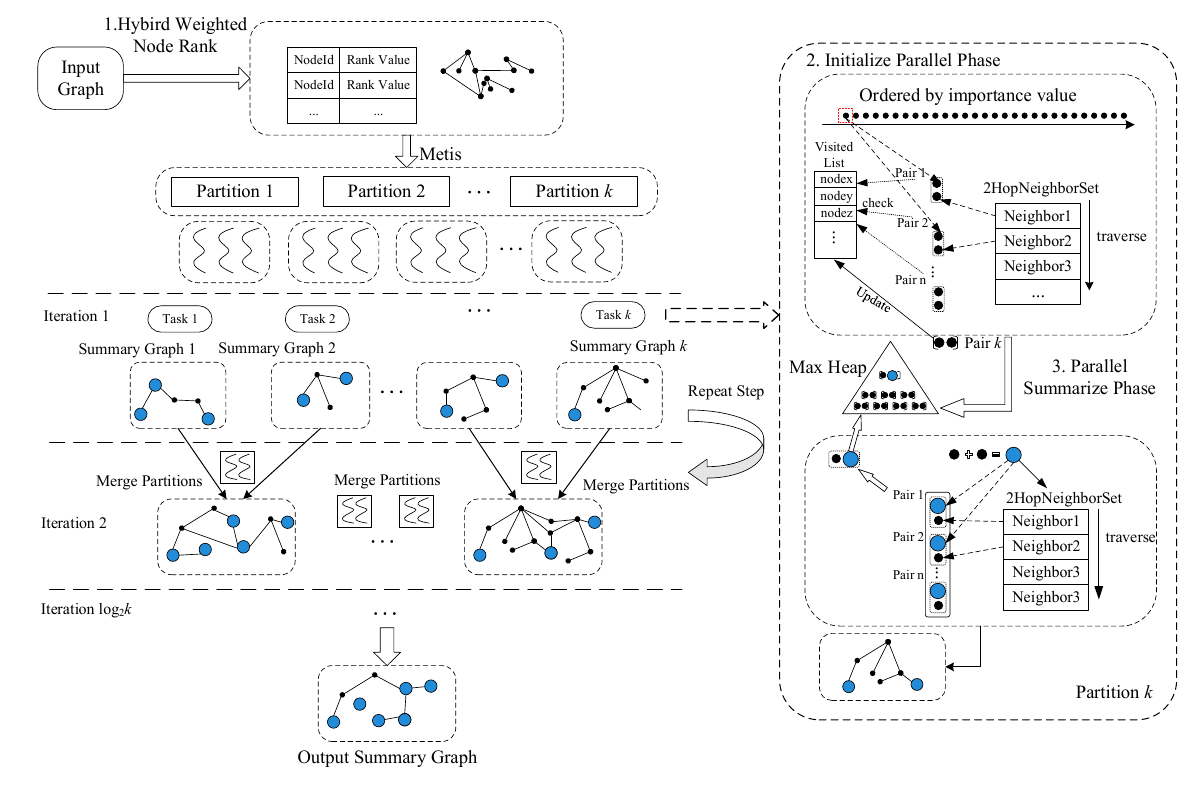
Figure 4. HRNS implementation architecture.